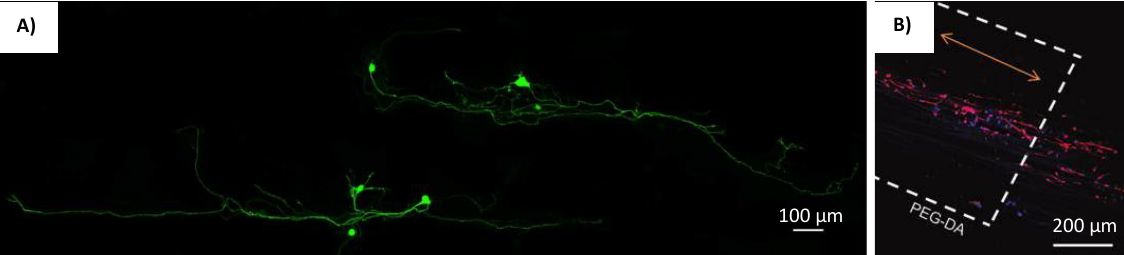
Figure 7. Cells cultured on different bio-printed scaffolds. ( A ) DRG neurites aligned along 3D printed fibrin-factor XIII-HA strands [79]. Reprinted with permission copyright © 2016 Elsevier B.V. ( B ) Neurite growth of primary cortical neurons on scaffolds with PCL/gelatin fibers [81]. Reprinted with permission copyright © Mary Ann Liebert, Inc.